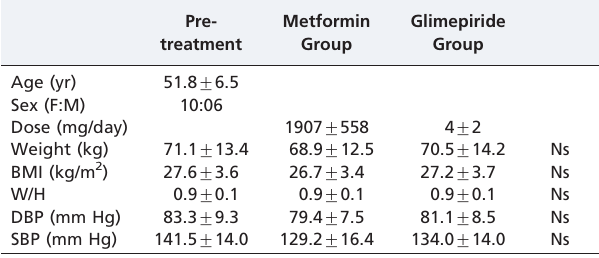
Table 1 - Anthropometric